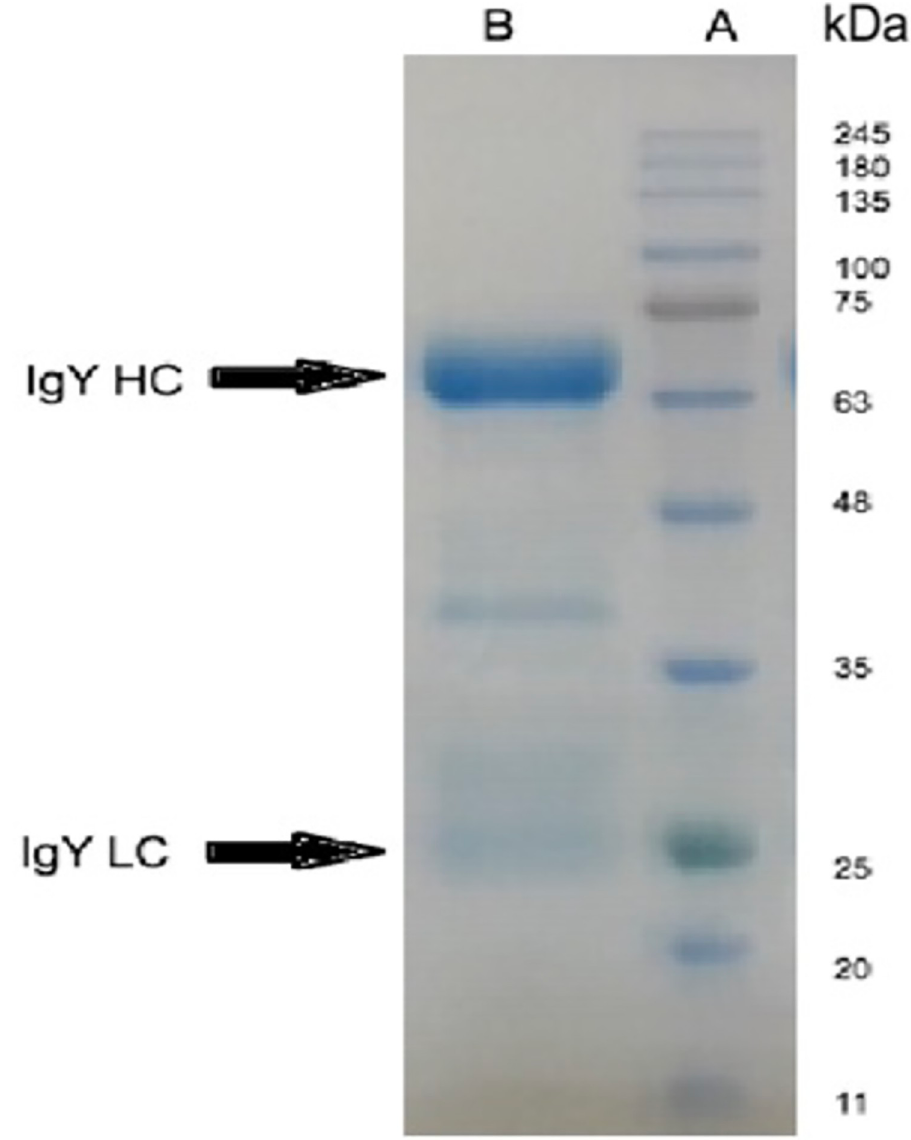
Fig 1. SDS-PAGE profile of the purified IgY antibodies. Lane A: standard protein ladder to indicate molecular mass in kilodaltons (kDa). Lane B: purified IgY with the heavy chain and light chain indicated as HC and LC, respectively.